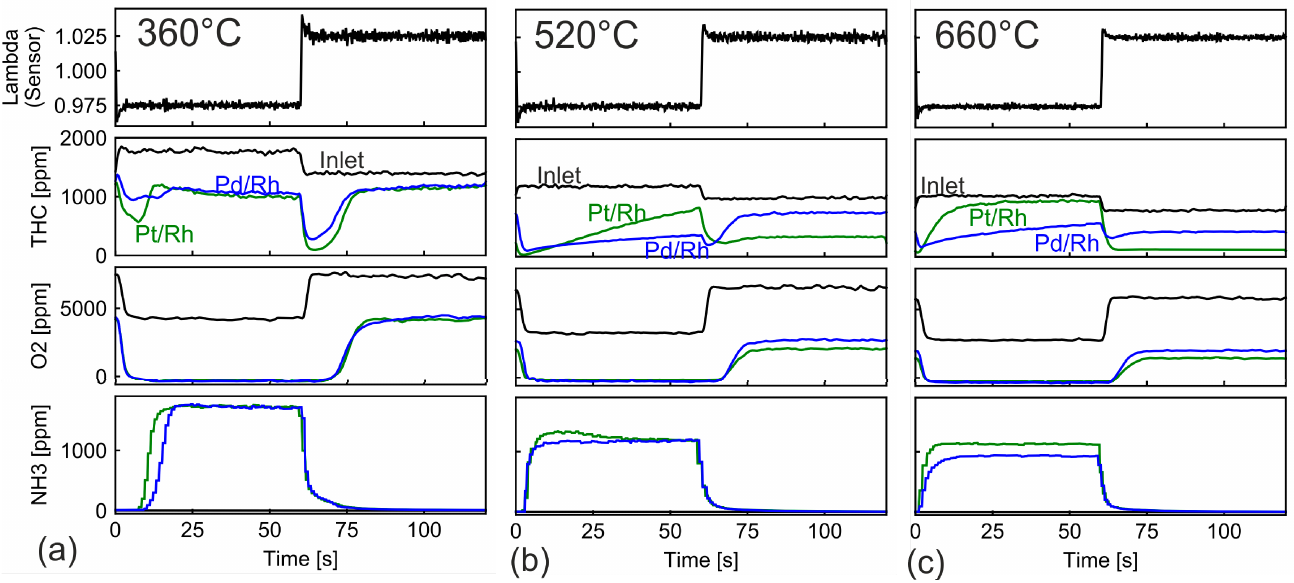
Figure 10. THC, O 2 and NH 3 Concentration profiles during slow λ oscillations at ( a ) 360 °C ( b ) 520 °C and ( c ) 630 °C in Pt/Rh and Pd/Rh catalyst.